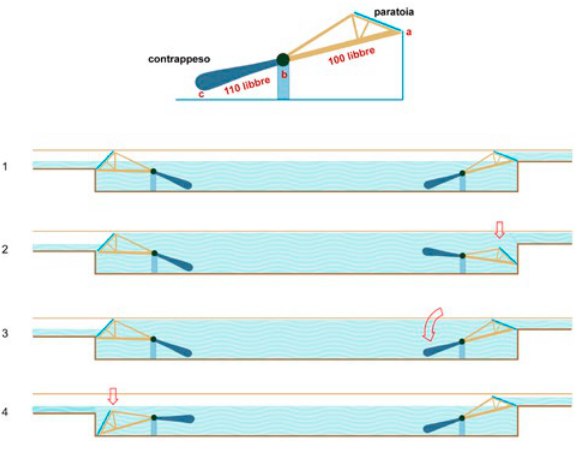
Figure 27. Operation of the counterweight system designed to sup- port one braccio of water.